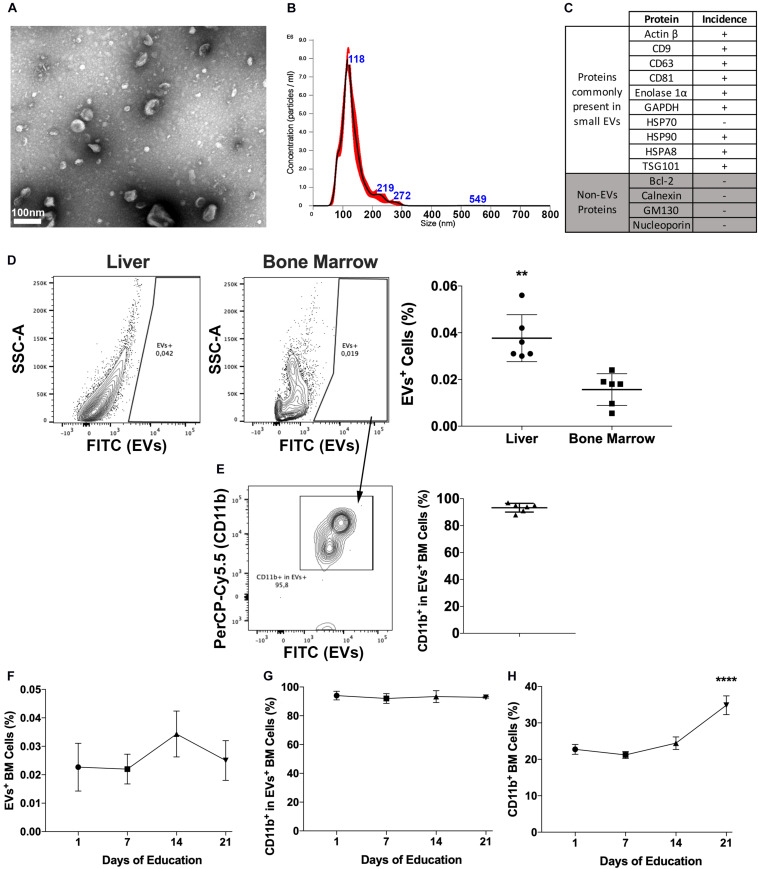
Pancreatic cancers-derived EVs binding to BM cells. (A) Representative transmission electron microscopy of PAN02 EVs. (B) Representative Nanoparticle Tracking Analysis of PAN02 EVs. (C) Proteins frequently present and absent in small EVs, studied in PAN02 EVs by Protein Mass Spectrometry. (D) PC-EVs are taken up by liver and BM cells, 24 h post-injection. (E) Most of the cells that take up PC-EVs are CD11b+ BM cells. (F) Three-week education with PC-EVs does not modify the incidence of EV+ BM cells or CD11b+ cells within cells that take up PC-EVs (G). (H) Three-week education with PC-EVs induces the increase of BM CD11b+ cells. **P < 0.01, ****P < 0.0001 by ANOVA.